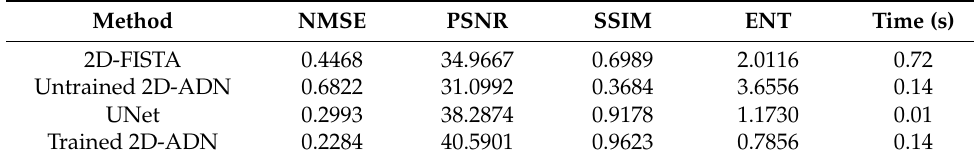
Figure 13. Images of the incomplete azimuth data with data missing pattern shown in Figure 8d, which are obtained by ( a ) 2D ‐ FISTA, ( b ) untrained 2D ‐ ADN, ( c ) UNet, and ( d ) trained 2D ‐ ADN. Table 6. Quantitative performance evaluation for the incomplete azimuth simulation data.